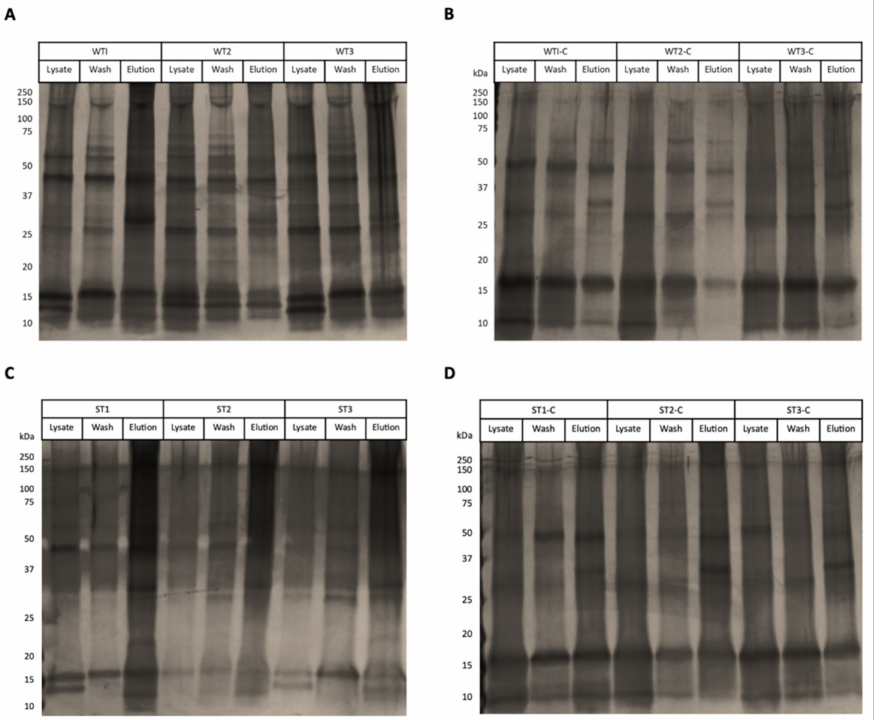
Figure 3. Protein profiles of abomasal whole tissue (WT) and abomasal scrape tissue (ST) extracts that bound to Tci-gal-1. Silver stained 12% ( w / v ) SDS-PAGE gels showing protein abomasal whole tissue and scrape tissue lysates bound to immobilised Teladorsagia circumcincta galectin (Tci-gal-1). ( A ) Lysate, wash and elution prepared from sheep abomasal whole tissue added to immobilised Tci-gal-1, performed in triplicate. ( B ) Lysate, wash and elution prepared from sheep abomasal whole tissue, treated with 20 mM sodium periodate, added to immobilised Tci-gal-1, performed in triplicate. ( C ) Lysate, wash and elution prepared from sheep abomasal scrape tissue added to immobilised Tci-gal-1, performed in triplicate. ( D ) Lysate, wash and elution prepared from sheep abomasal scrape tissue, treated with 20 mM sodium